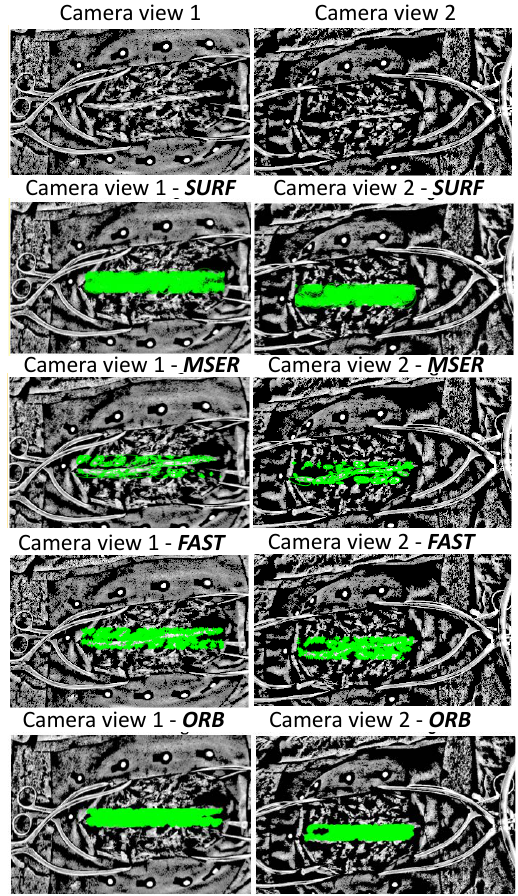
Figure 8. Detection of spine features in two image views (camera 1 and 2). The numbered views above the two columns of images, refer to the two cameras. In the first row the preprocessed images are shown. The subsequent rows illustrate results after applying the four feature detection algorithms (SURF, MSER, FAST and ORB). Green is used to indicate salient spine features identified by the respective